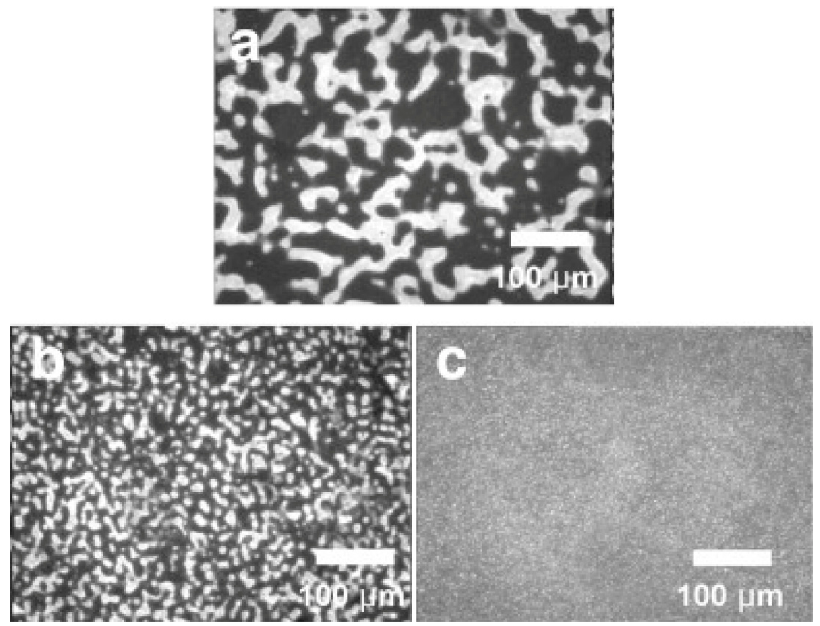
Figure 13. Fluorescence Images of ( a ) BA/SBS, ( b ) BA/SBS/20A PM, and ( c ) BA/SBS/20A MB (reprinted from [46] reprinted with the permission of Elsevier).